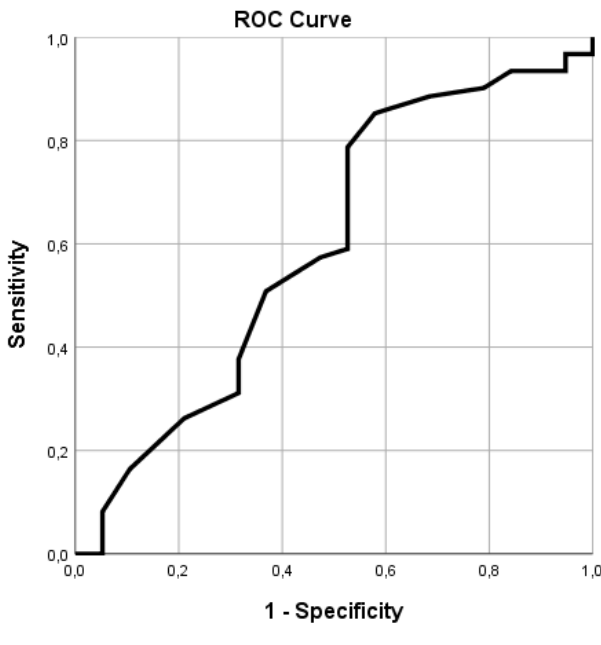
Fig. 5 – ROC curves for ejection fraction value – postoperative sinus rhythm. ROC=receiver operating